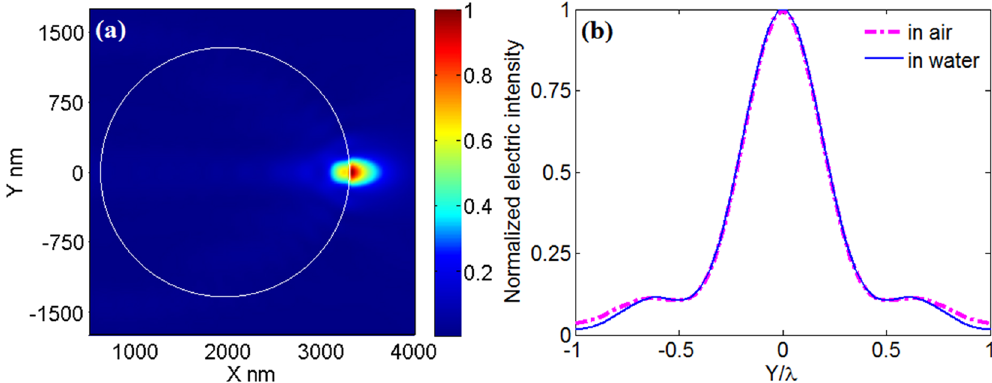
Figure 5. ( a ) Electric intensity distribution around the microsphere immerged in deionized water. The system parameters are: